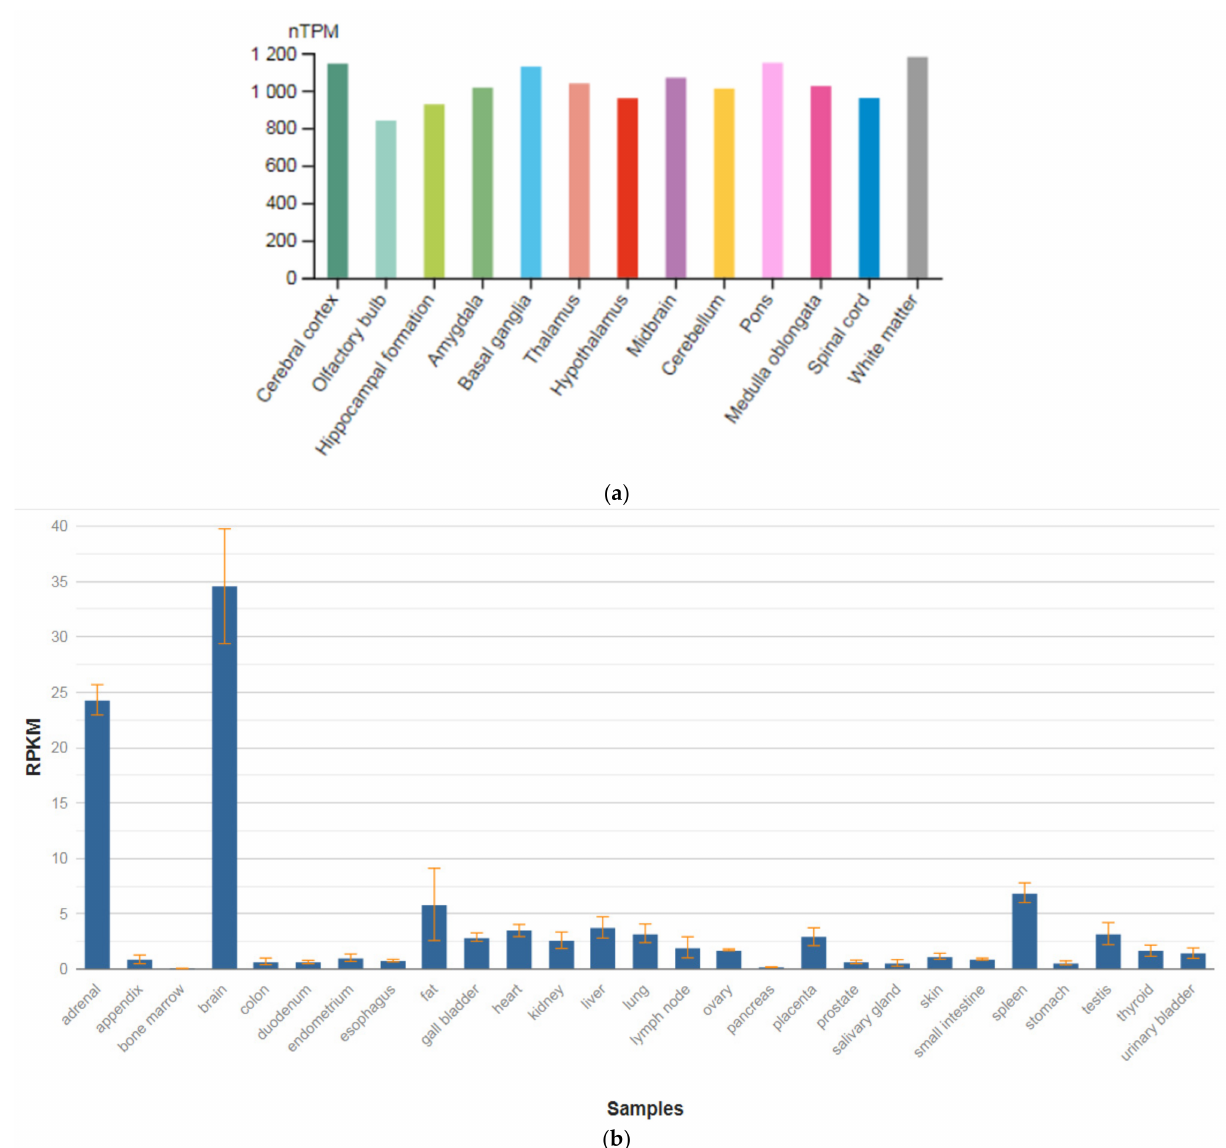
Figure 4. The tissue expression of the septin type 4 in the brain ( a ) and other organs in the human body ( b